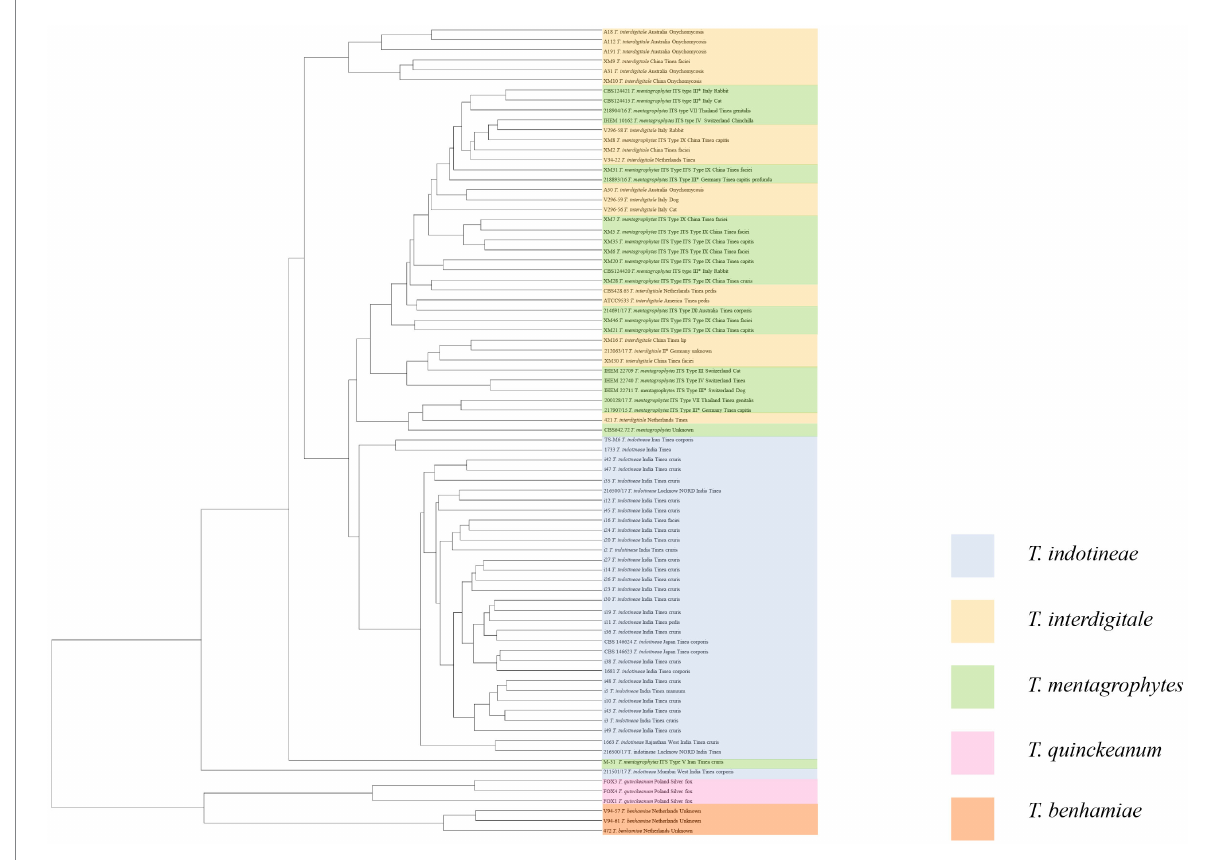
FIGURE 1 Distance dendrogram of MALDI-ToF MS analysis of T. mentagrophytes species complex. T. benhamiae is